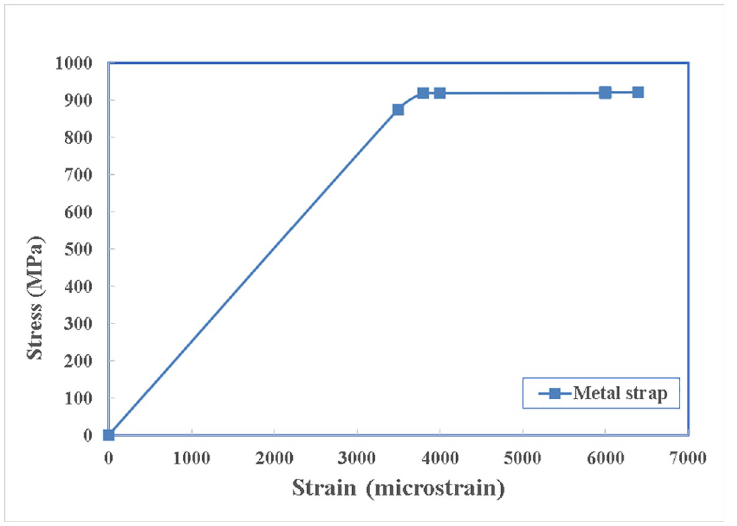
Fig 3. Manufacturer’s load- strain diagram of the metal